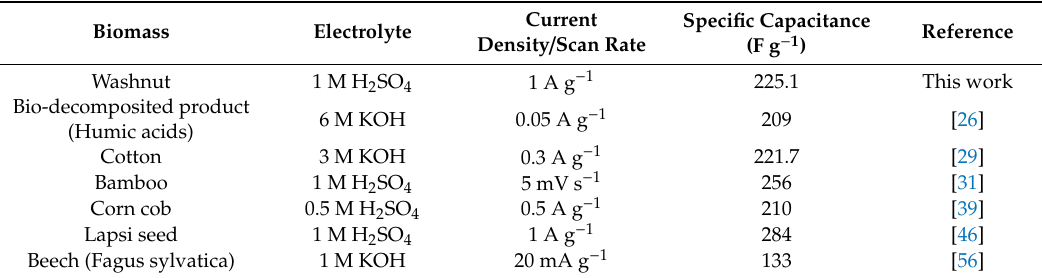
Table 2. Comparison of specific capacitance of the Washnut carbon electrode with other biomass-derived nanoporous carbon electrodes.